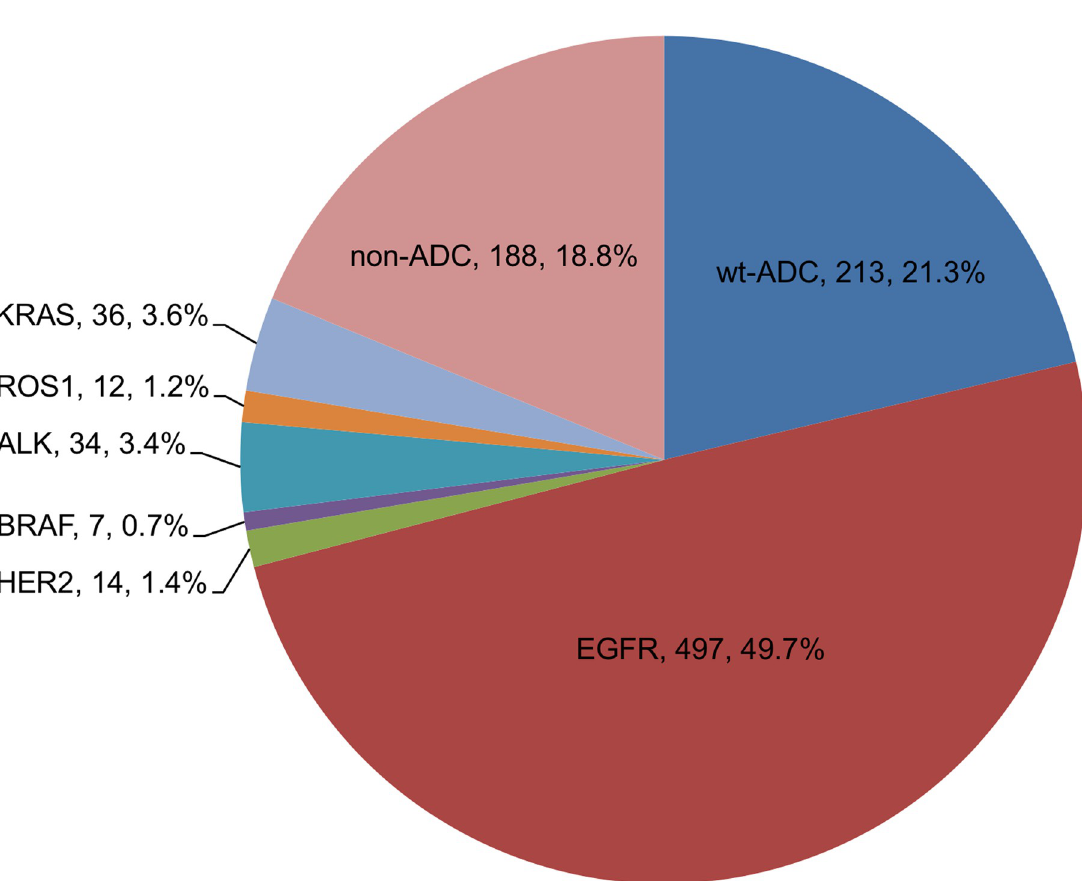
Fig 1. Histology and genotype distribution of NSCLC. ADC, adenocarcinoma; wt, EGFR and ALK -wild type.